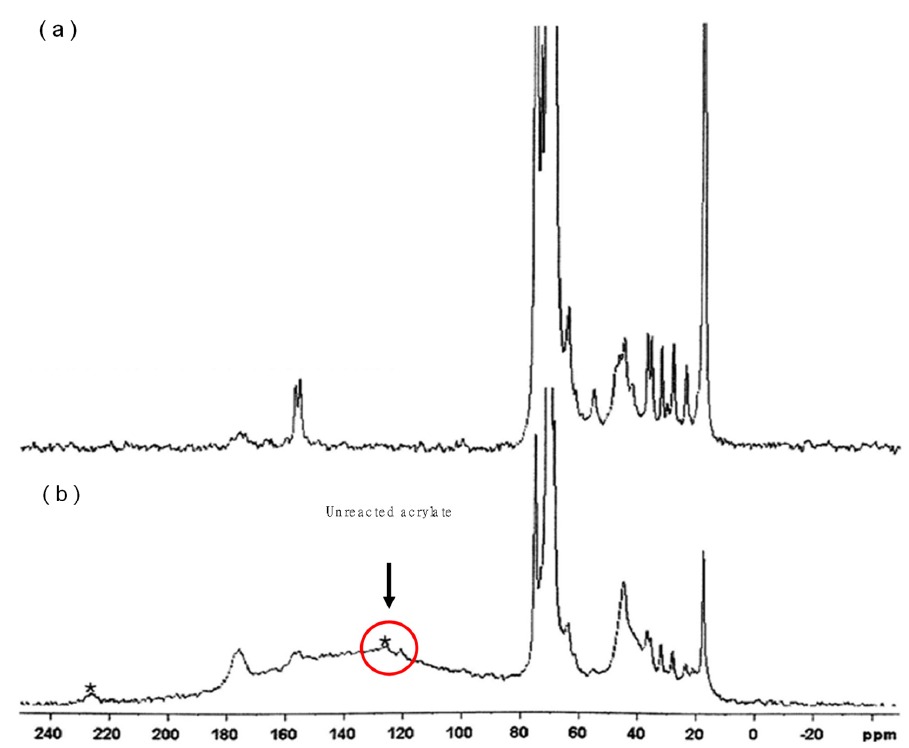
Figure 4. Solid NMR results of pellet prepared ( a ) with crosslinker (1.6%) ( b ) and without crosslinker (0%).